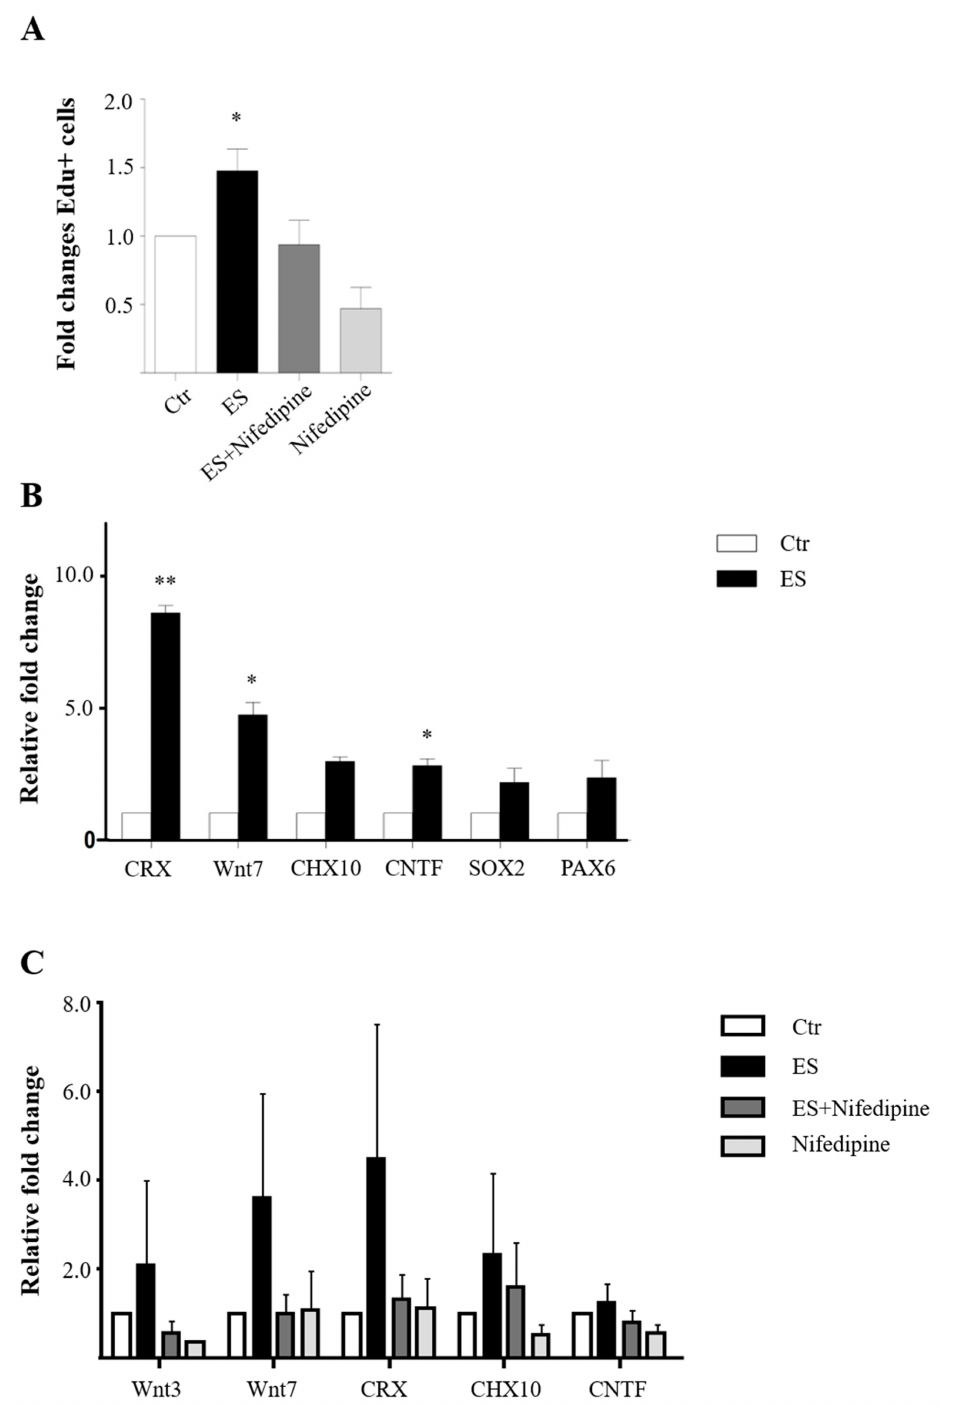
Figure 5. Essential involvement of calcium for ES-induced MC proliferation. ( A ) Improved MC proliferation after ES and the loss of this e ff ect in the presence of 1 µ M nifedipine (* p < 0.05, paired t -test). ( B ) Results of qPCR showing upregulation of progenitor cell markers and the neurotrophic factor Cntf in cultured MC at 48 h after ES with ** p < 0.005 and * p < 0.05 compared to sham treated control with paired t -test. ( C ) Nifedipine blocked ES-induced upregulation of progenitor markers such as Wnt3 , Wnt7 , Crx , and Chx10 in cultured